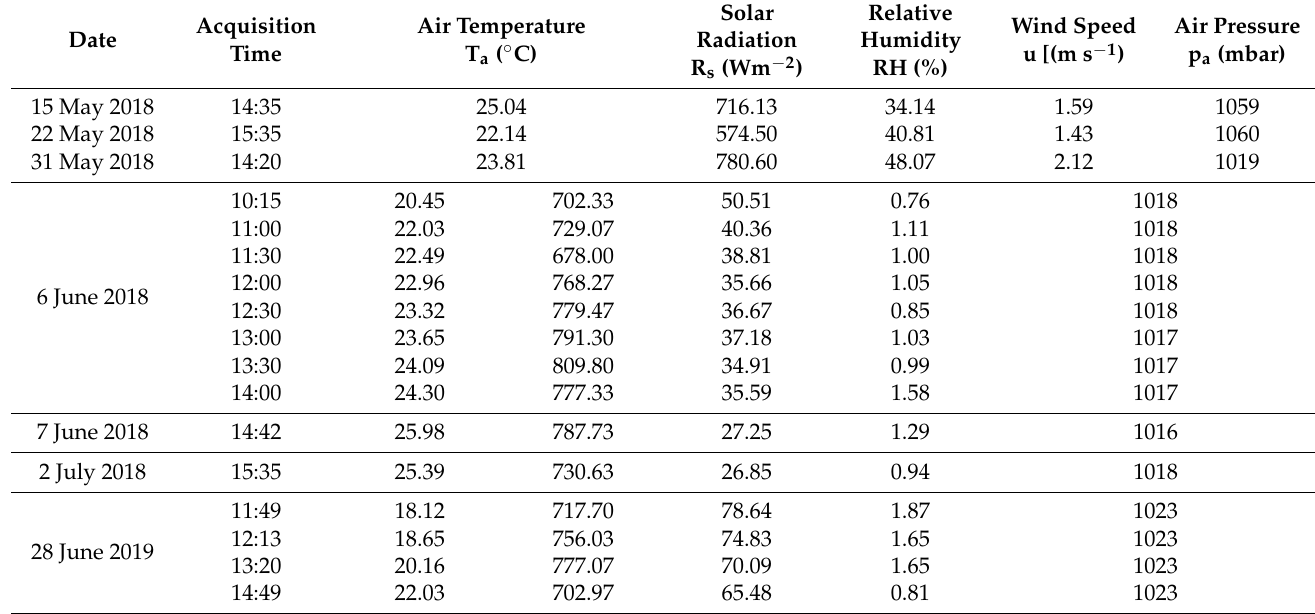
Table A1. Atmospheric conditions for the season 2018 on half-hour scale at the time of the UAS